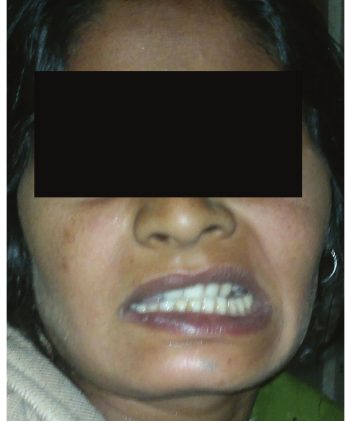
Figure 2: Inability to show teeth (right